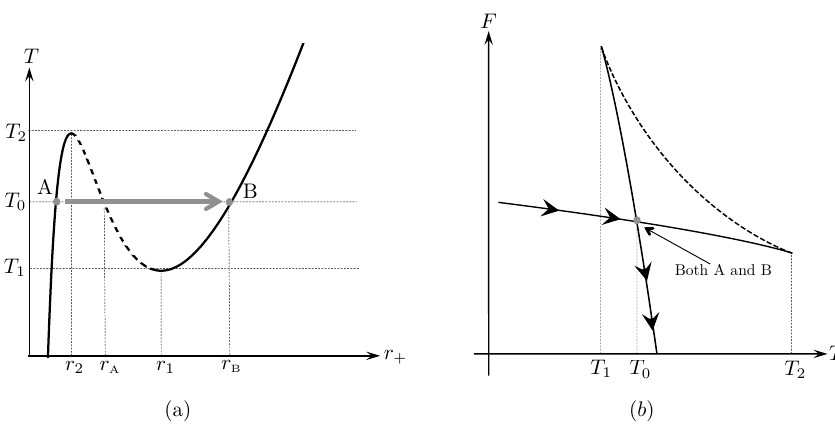
Figure 2 . Figure (a) is a graph of the temperature of the black hole solution as a function of the horizon radius r + in the case of negative cosmological constant with j (cid:3) j < 1 with T = 0 is the smallest possible black hole, and it corresponds to the vacuum solution M =